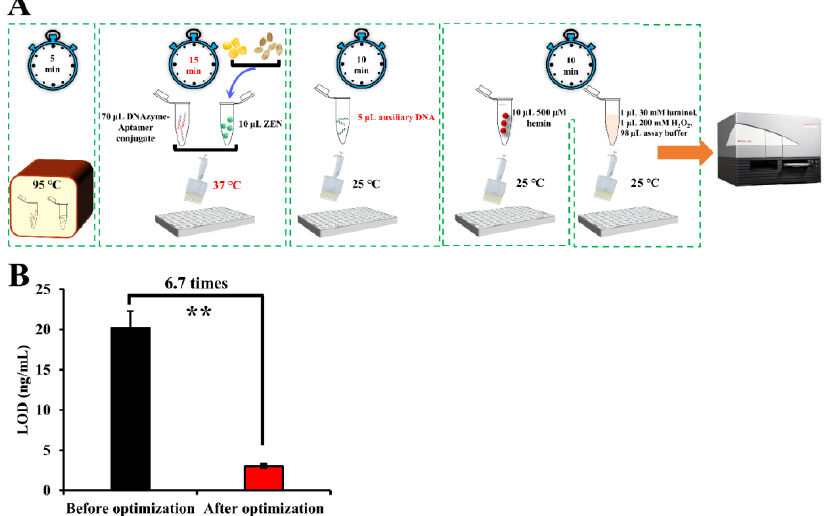
Figure 3. Schematic representation of the detection procedures ( A ) and improved LOD ( B ) of our proposed sensing system after the optimization process. Note: “**” denotes a very significant dif- ference ( p < 0.01) after S tudent’s t -test.